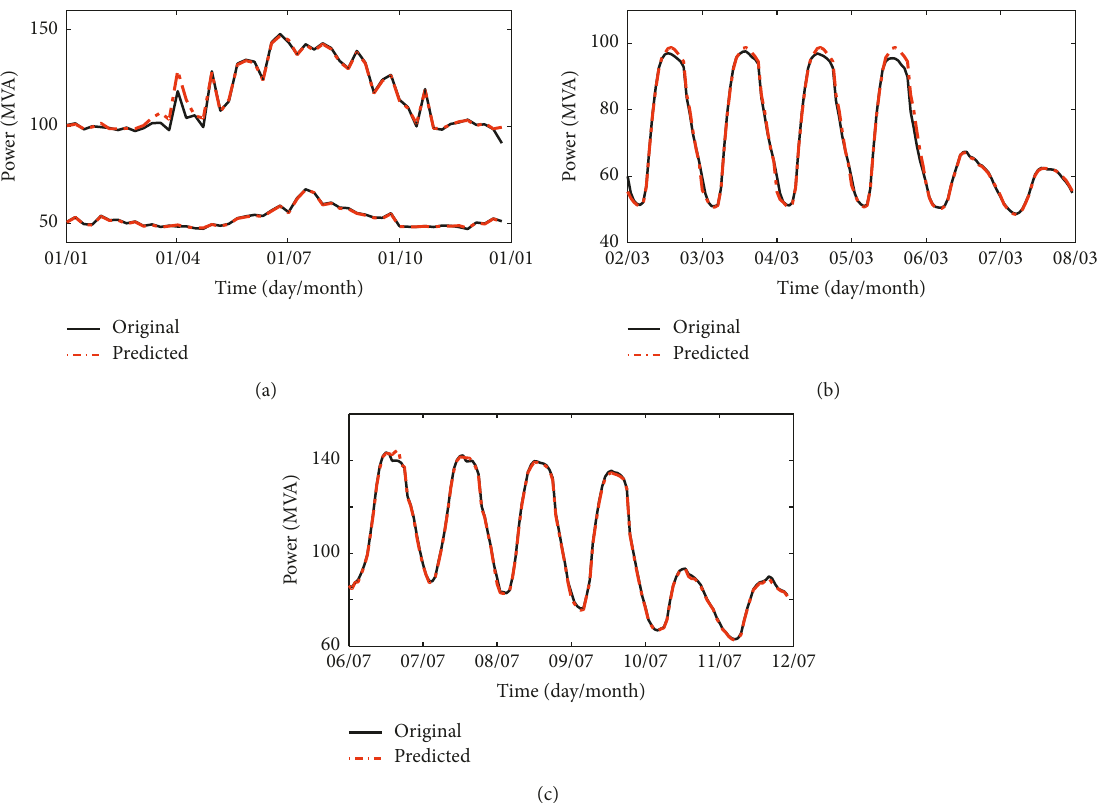
Figure 11: Comparison between the original load shapes and forecasted load shapes based on effective temperature: (a) entire year load shape envelope; (b) valley; (c) peak.